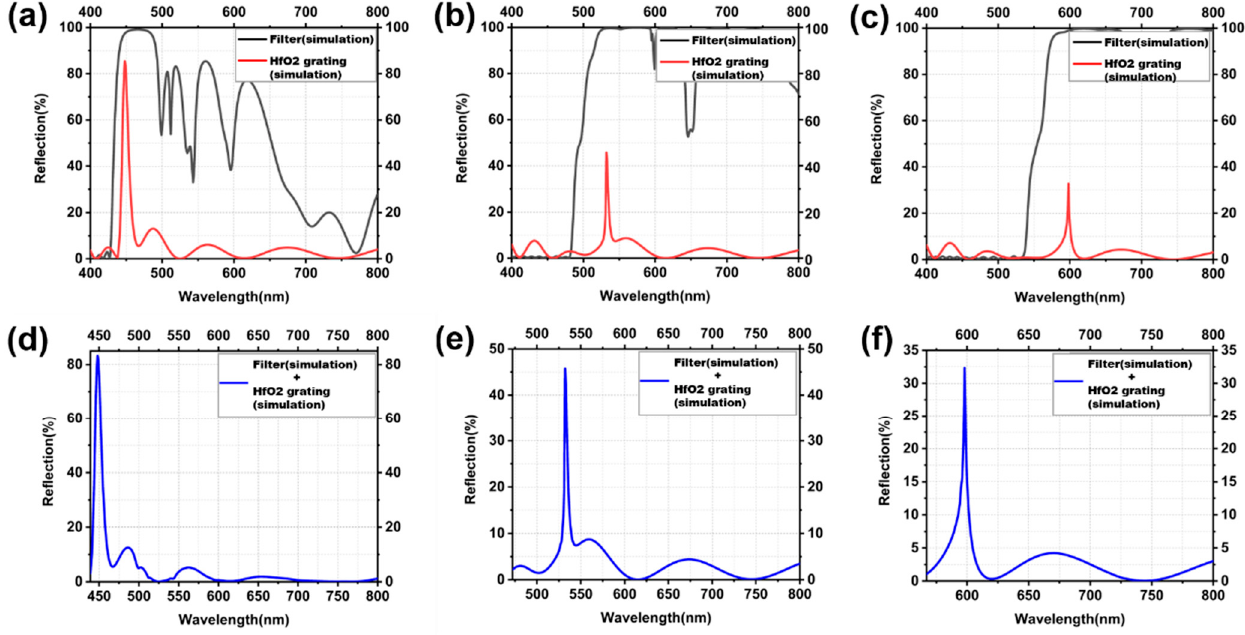
Figure 4. The light is incident at 45°, ( a – c ) correspond to the blue, green, red, and black lines in the optical three primary colors represent the reflection spectrum of the filter, and the red line represents the reflection spectrum of the HfO 2 grating. ( d – f ) Reflectance spectrum of filter and HfO 2 grating. The location of the chromaticity coordinates on the chromaticity diagram is undoubt- edly one of the best ways to judge the quality of structural colors. The CIE 1931 chromaticity diagram describes a color space mathematically. Chromaticity coordinates are defined as ( x , y ), which are calculated from tristimulus values ( X , Y , Z ), x = X /( X + Y + Z ), y = Y /( X + Y + Z ). Tristimulus values are determined by Equations (3)–(5) [32]: